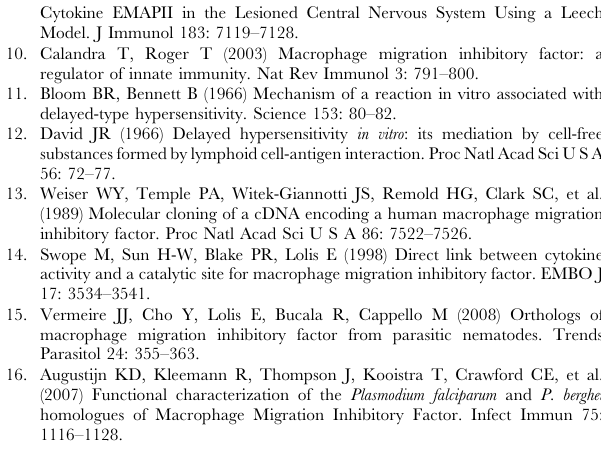
Figure S2 BgMIF concentrations in snail plasma decrease after S. mansoni infection. After 0 h, 6 h, 24 h and 48 h infection by S. mansoni miracidia BgMIF levels in snail plasma were quantified by indirect ELISA tests. Results are the means + / 2 S.D. of the triplicate of two different infection experiments (* p , 0,05; ** p , 0,001). Figure S3 The MEK inhibitor U0126 prevents the stimulatory effect of BgMIF on Bge cell proliferation. The proliferation rate of Bge cells treated with 10 m M of U0126 or DMSO (solvent) was measured in the presence of various concentrations of rBgMIF. an ELISA assay. Results are represented as fold increase in BrdU incorporation as compared to incorporation in control cells. The results shown are the mean 6 SD of two assays carried out in quadruplicate and are representative of 3 separate experiments * p , 0,05. Table S1 Oligonucleotide primers used in the